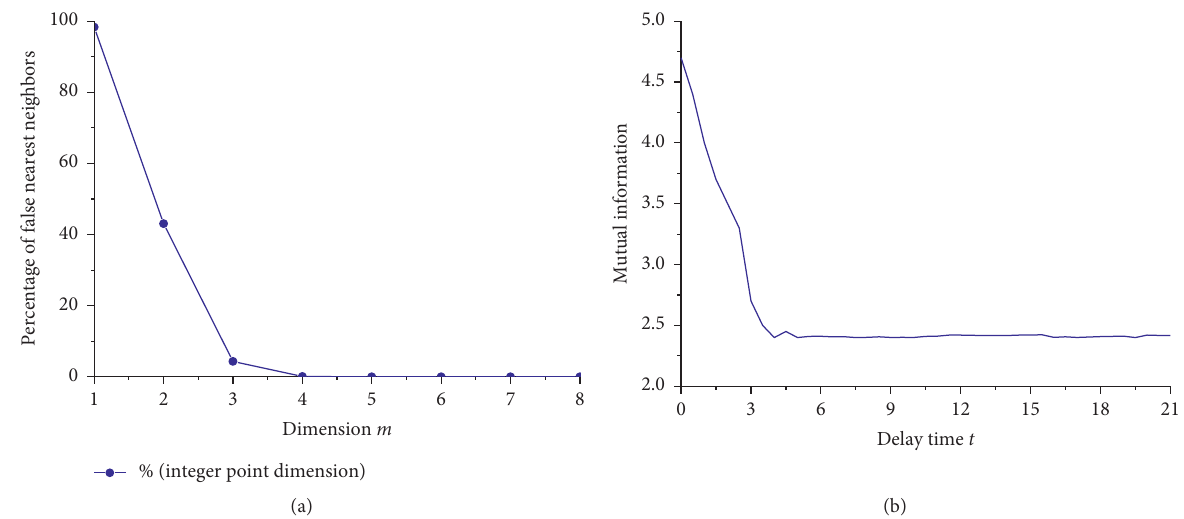
Figure 7: Selection of parameters for phase space reconstruction. (a) The determination of the embedding dimension by false nearest neighbor method. (b) Determination of delay time by mutual information method.